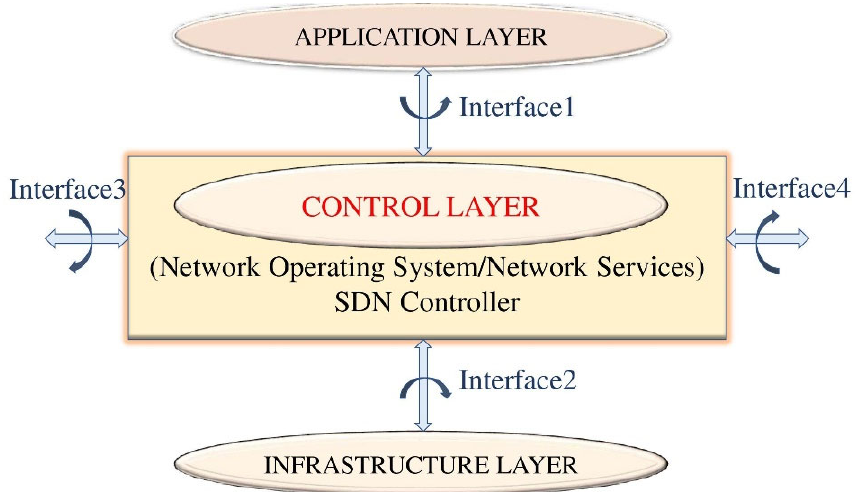
Figure 1. Architecture of SDN layer.